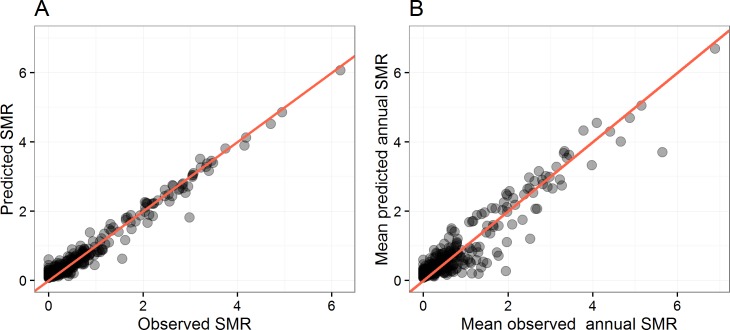
Comparison between observed and predicted SMR for both models.(A) Goodness-of-fit for the spatial-only model, Model 1. (B) Goodness-of-fit for the spatio-temporal model, Model 2. Goodness-of-fit was computed by comparing the observed standardised morbidity ratio (SMR, i.e. observed-to-expected cases) for each village of the study area with those computed from the spatial-only and spatio-temporal models. Solid diagonal line indicates where values should lay for a perfect correspondence between predictions and observations. Inferences from Model 2 were averaged at village level to provide a proper comparison with Model 1.